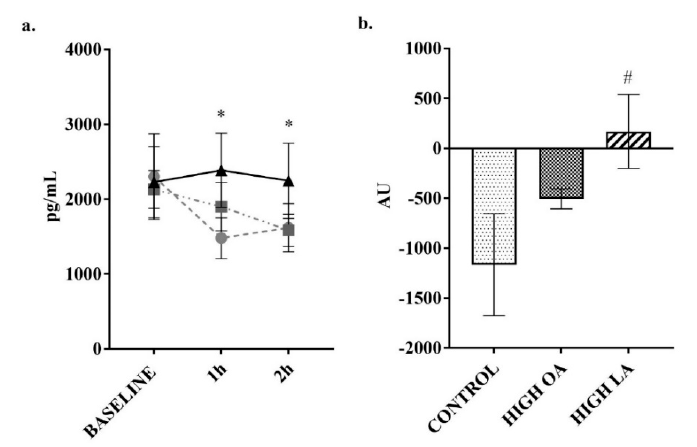
Figure 6. Change in ghrelin over 2 h postprandial period. ( a ) plotted values, = control meal, (cid:4) = high-OA, (cid:78) = high-LA; ( b ) Net AUC from baseline. Measured in plasma using a multiplex immunoassay. All data displayed as mean ± SEM, all data points n = 8. * = significantly different ( p < 0.05) at this time point compared to baseline for control meal. # = significantly different ( p < 0.05) to control meal.